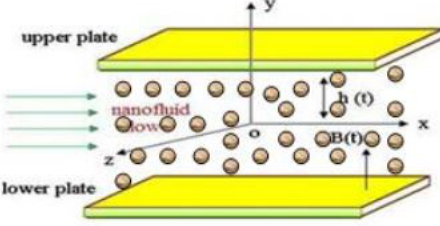
Figure 1. Model diagram of MHD squeezing flow of nanofluid between two parallel plates embedded in a porous